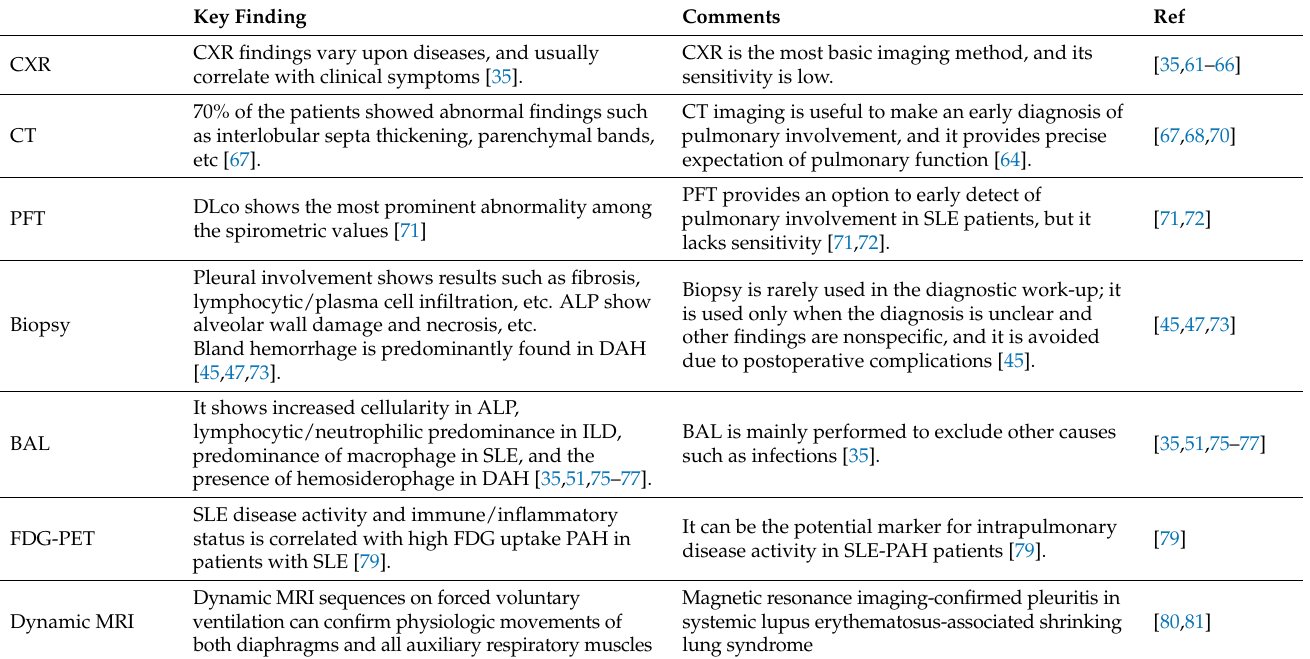
Table 2. Summary of the characteristics of the diagnostic tools to diagnose pulmonary involvement in